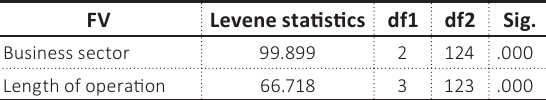
Table 3. Test of homogeneity of variances